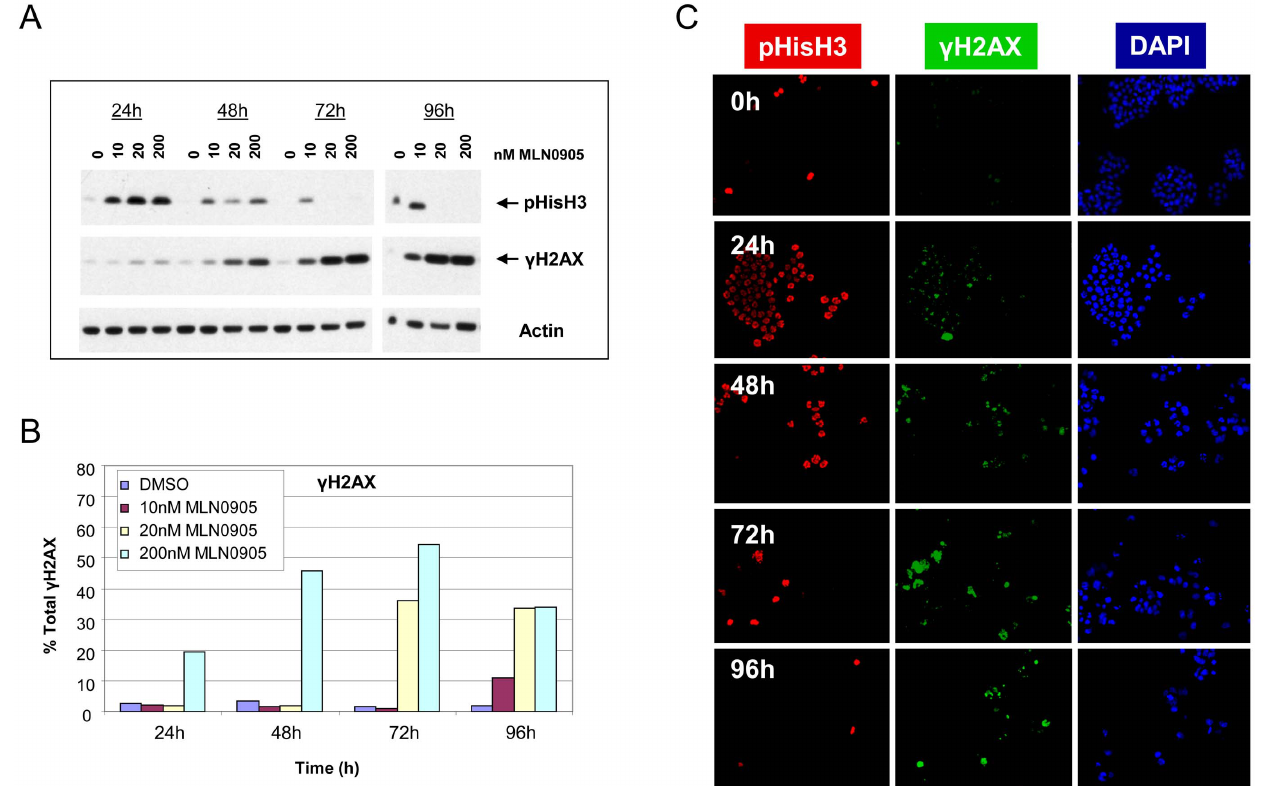
Figure 2. Plk1 inhibition leads to prolonged mitotic arrest followed by detection of DNA damage in HT-29 cells. Cells were treated with increasing concentrations of MLN0905 and mitotic arrest (via pHisH3) and DNA damage (via c H2AX) were analyzed at indicated times. A) Immunoblotting was used to demonstrate prolonged mitotic arrest precedes DNA damage (representative blot shown from two independent experiments). B) The same samples used in A) were quantified for DNA damage ( c H2AX) using FACS analysis. C) In a separate experiment immunofluorescent chemistry was also used to demonstrate mitotic arrest (pHisH3) precedes DNA damage ( c H2AX) (representative images shown from two independent experiments; 200 nM MLN0905 used).